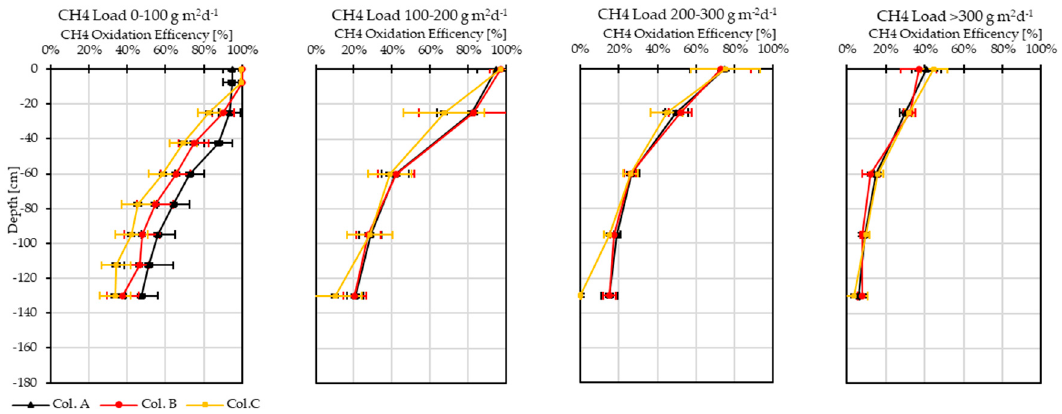
Figure 3. Average methane oxidation profiles for each CH 4 configuration load.